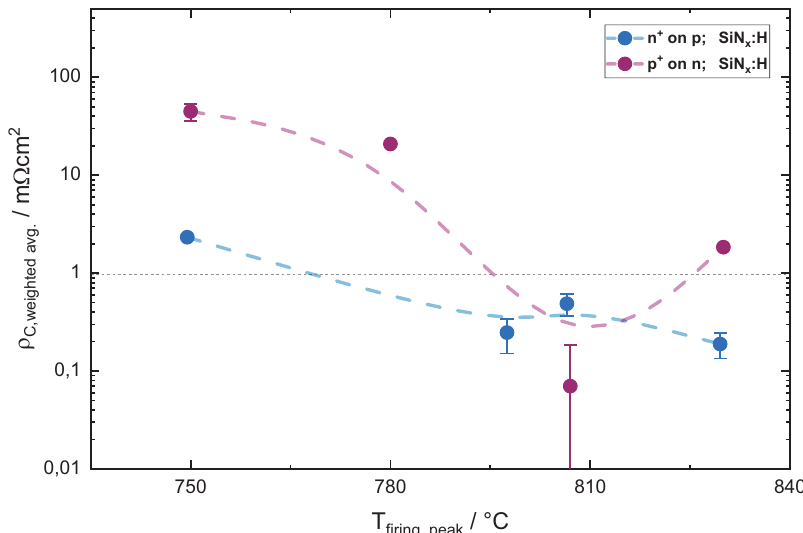
Fig. 2. Contact resistivity depending on sample peak fi ring temperature for the same Ag paste on different emitter types passivated with SiN x :H. For both polarities, contact resistivities below 1 m V cm 2 could be reached. Lines serve as a guide to the eye only.